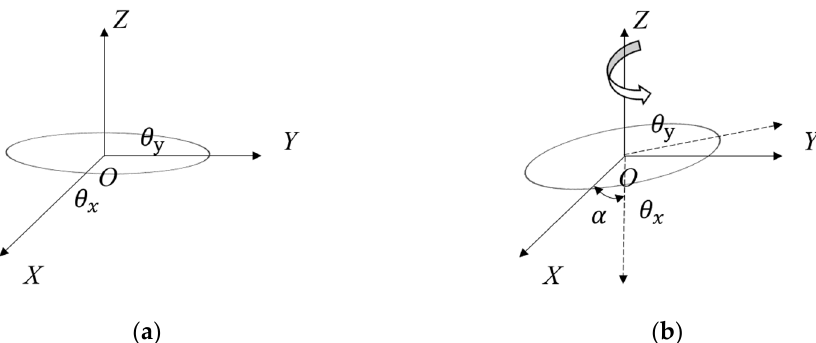
Figure 5. Correlation distance of different related structures. ( a ) Schematic diagram of the correlation length of z = 0; ( b ) correlation length of rotational anisotropy after rotation of the α angle about the Z -axis.